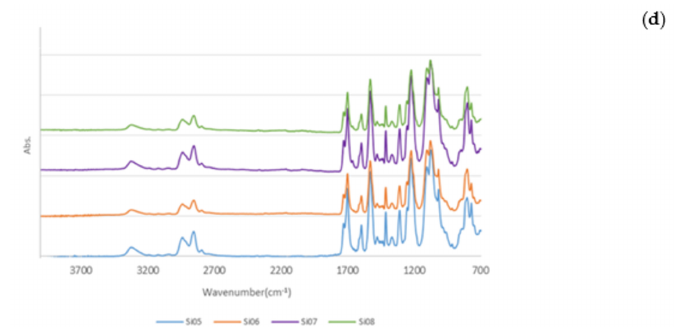
Figure 6. FTIR spectra of PU and PUSX Si01 nanofibers ( a ), block type PUSX nanofibers with various chain lengths ( b ), block type PUSX nanofibers with various silicone concentrations ( c ), graft type PUSX nanofibers with various chain lengths ( d